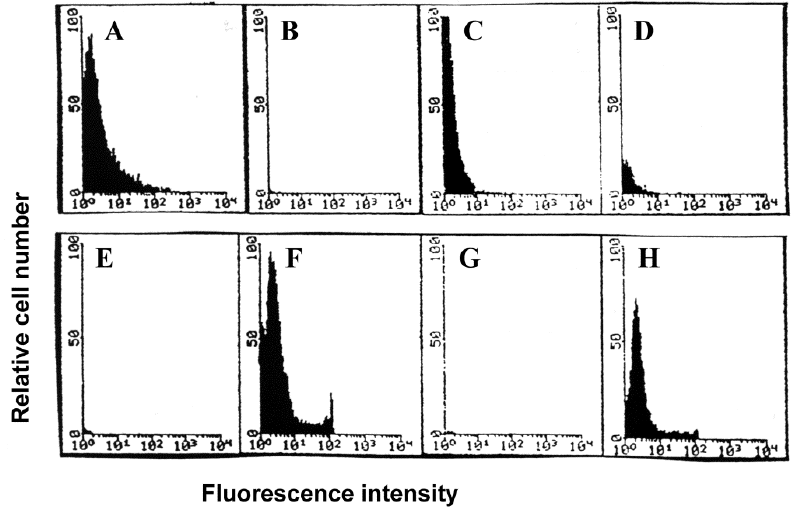
Figure 8. Flow cytometric analysis of binding and internalization of FITC-labeled influenza virus by lymphocytes. Lymphocytes were exposed to virus in the absence ( A , E and B , F ) or presence ( C , G and D , H ) of monocytes-macrophages. Cells (10 4 per panel) were analyzed 2 h after exposure for green ( A – D ) and red ( E – H ) fluorescence in the absence ( A , E and C , G ) and presence ( B , F and D , H ) of ethidium bromide. Sequential upper and lower pairs of panels (for example, A , E and B , F ) show results with the same population of cells analyzed before and after addition of ethidium